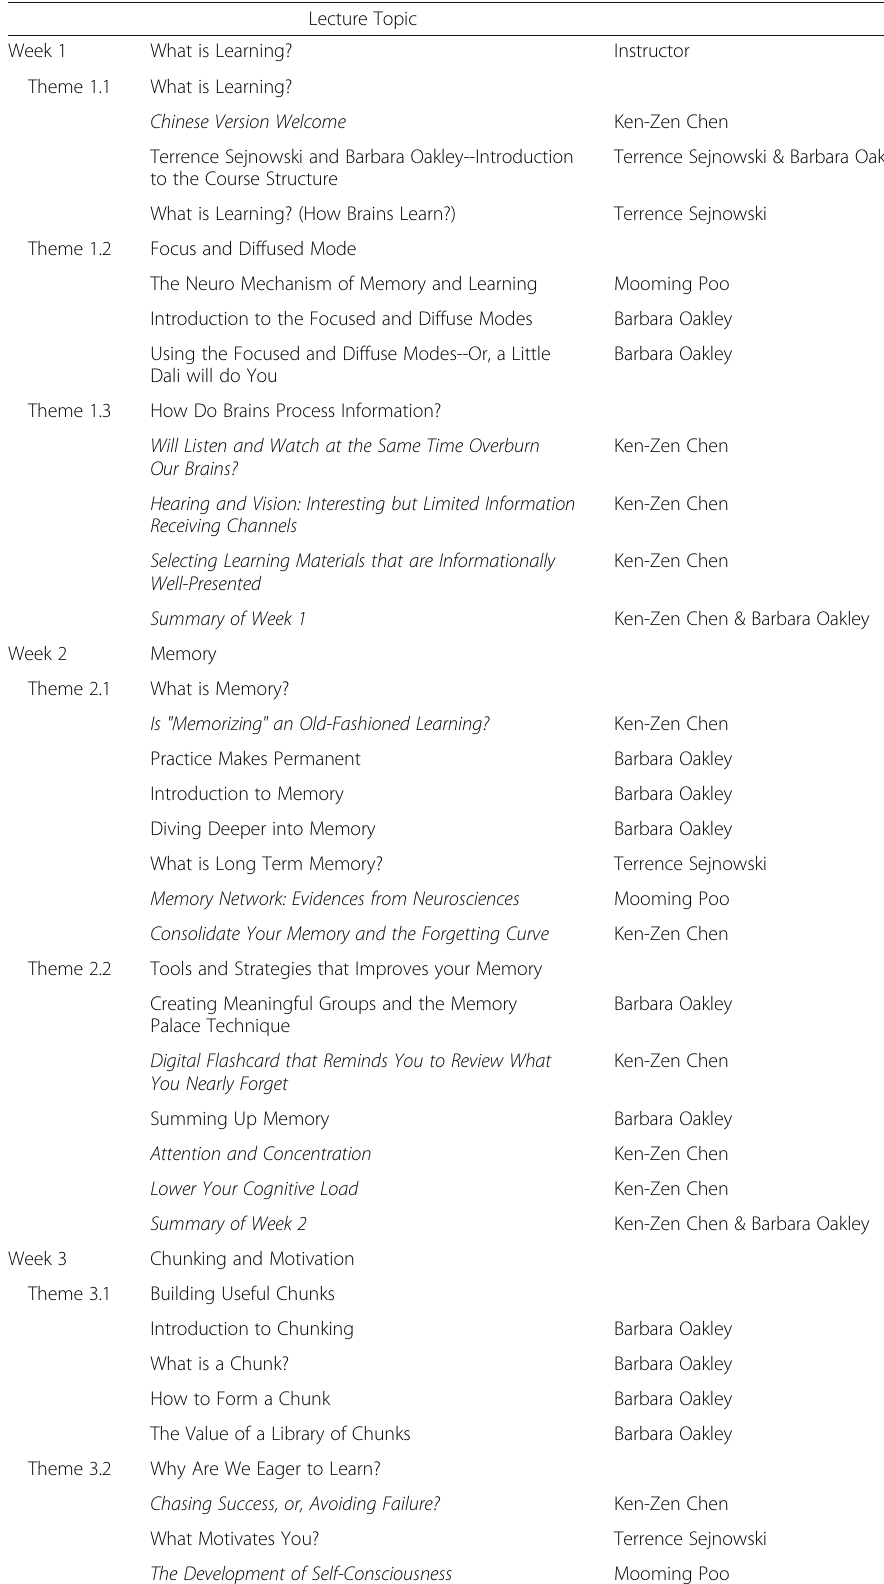
Table 3 The Lecture Topics of the Chinese